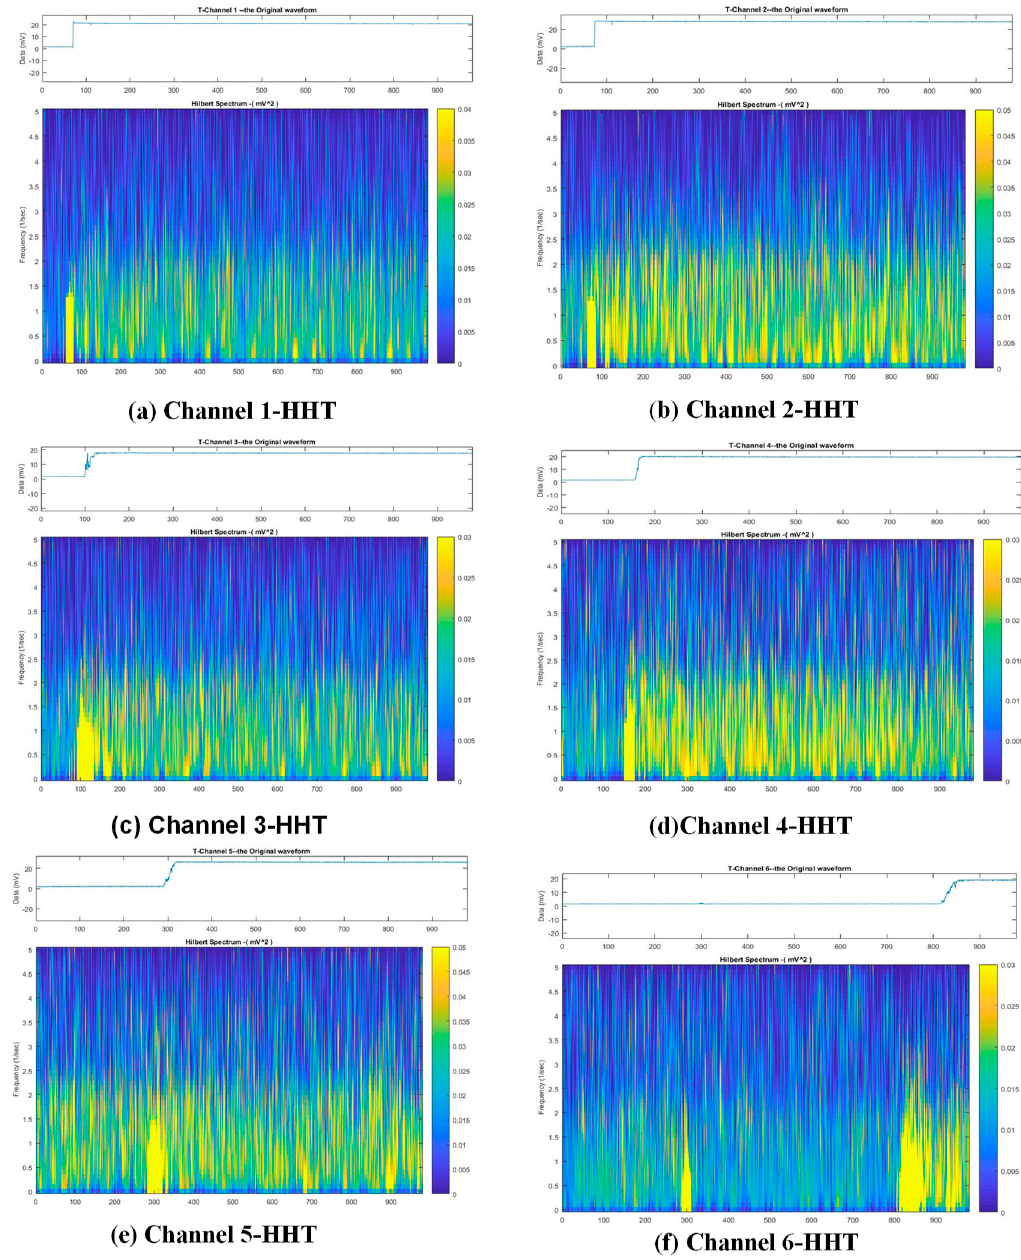
Figure 8. HHT diagrams for the first six sensors.